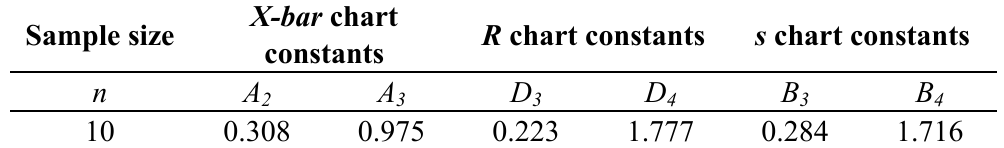
Table 1. Constants of upper and lower control limits for the X -bar charts, s charts, and R